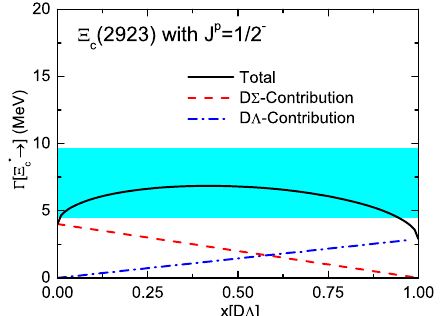
Fig. 5 Decomposed contributions to the decay width of the (cid:2) c ( 2923 ) into (cid:3) + c K − and π(cid:2) . The cyan bands denote the experimental total width